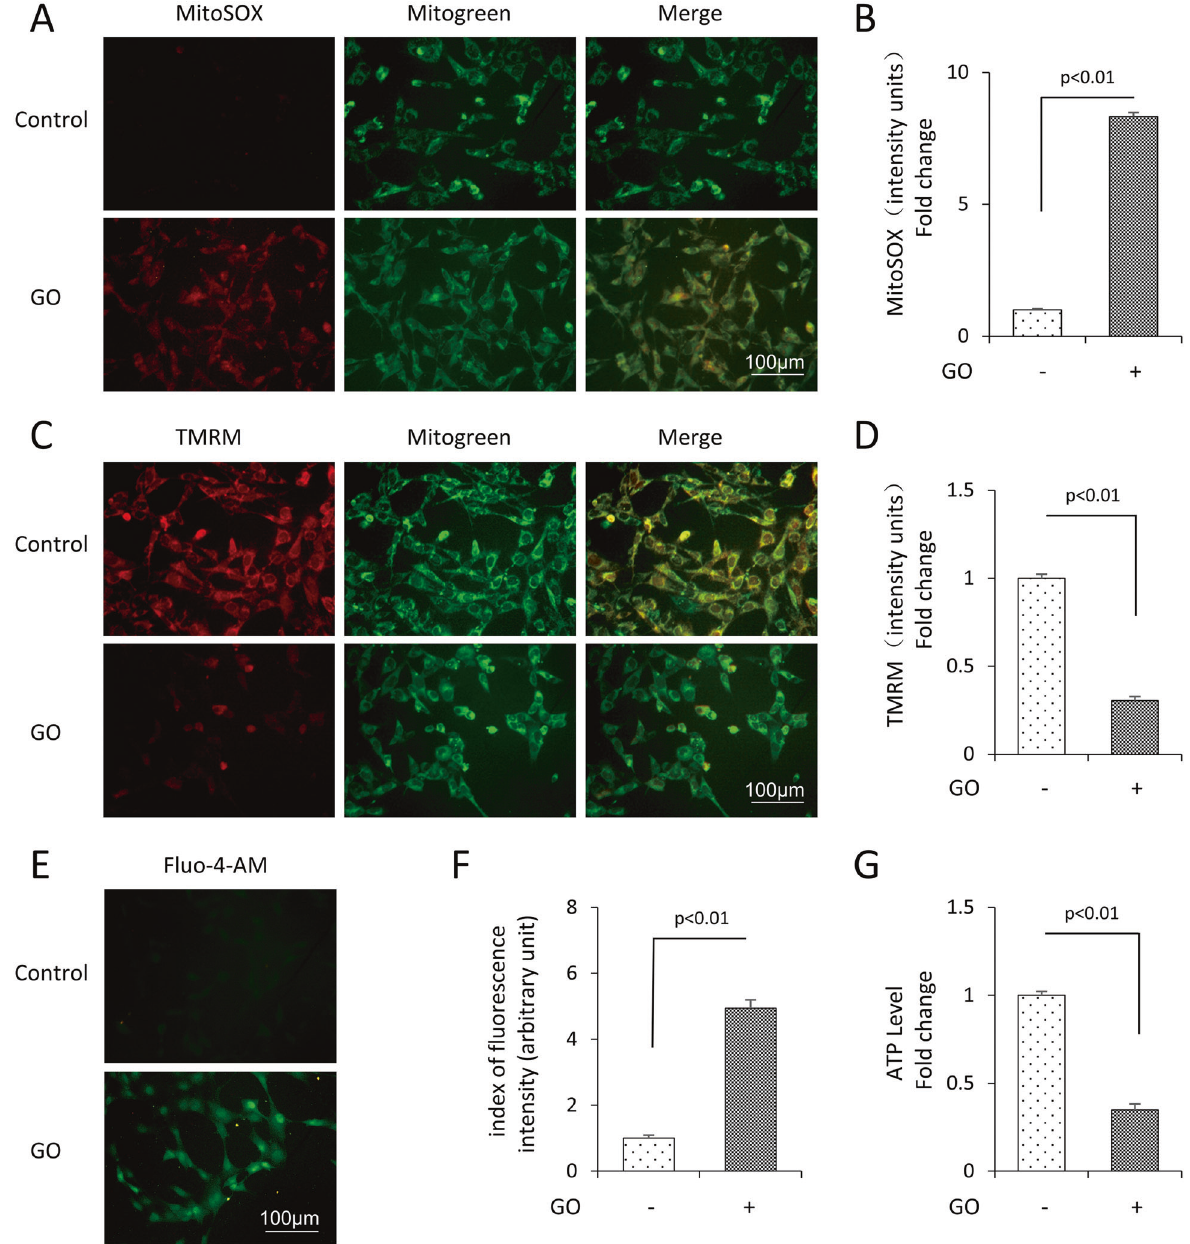
indicated groups. G ATP in the indicated groups. The values are expressed as the means ± SD ( n =